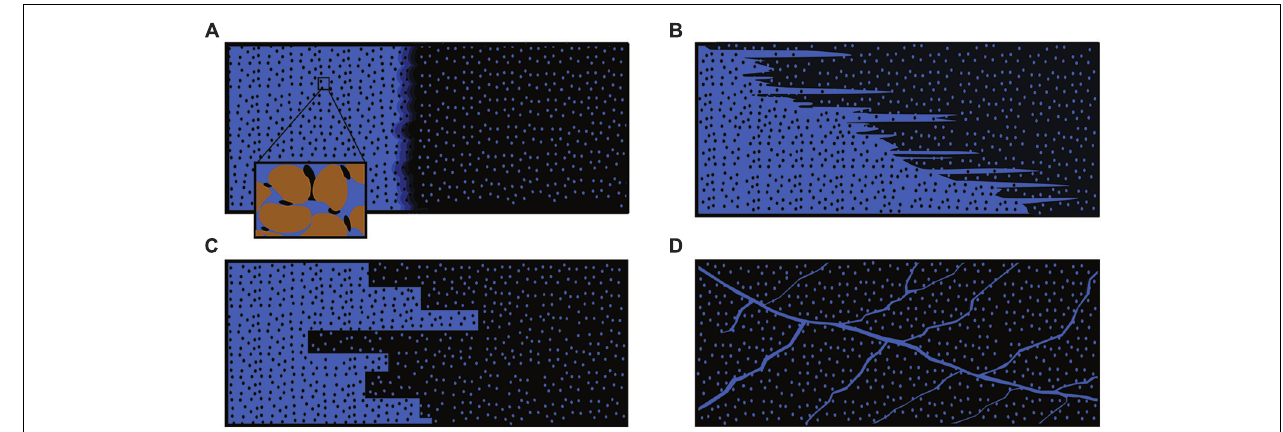
FIGURE 4 | Schematic representation of oil displacement in a petroleum reservoir. Ideal matrix piston-wise (stable) displacement leaving low residual oil levels (A) with the close-up showing the residual oil (black blobs) attached to sand grain particles (brown), unstable displacement showing fingering of water into the oil phase